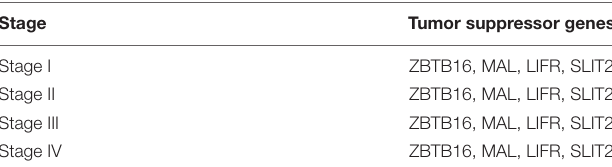
TABLE 7 | Tumor suppressor genes in stage I to stage IV associated with colon and rectal